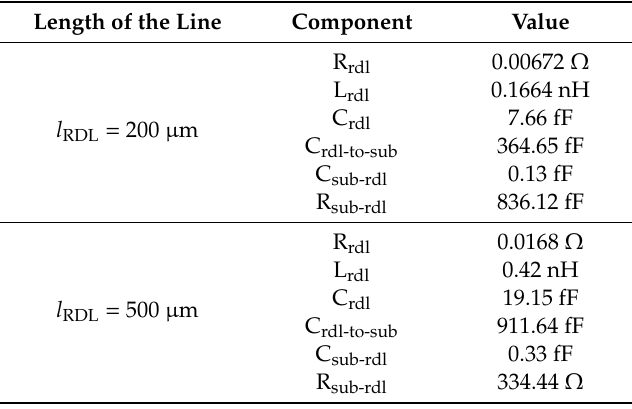
Table 3. Lumped circuit elements of the RDL.